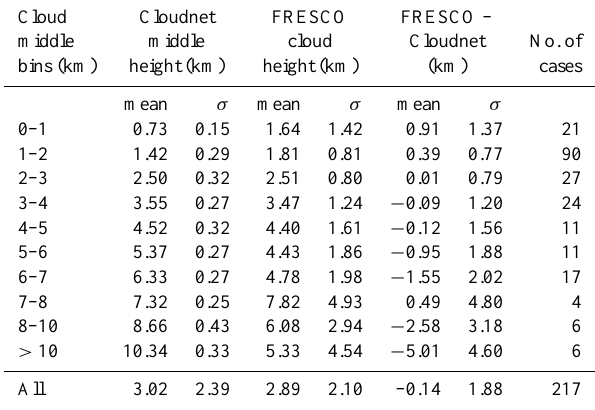
Table A3. Comparison of SCIAMACHY FRESCO cloud height with Cloudnet cloud middle height for single-layer clouds.